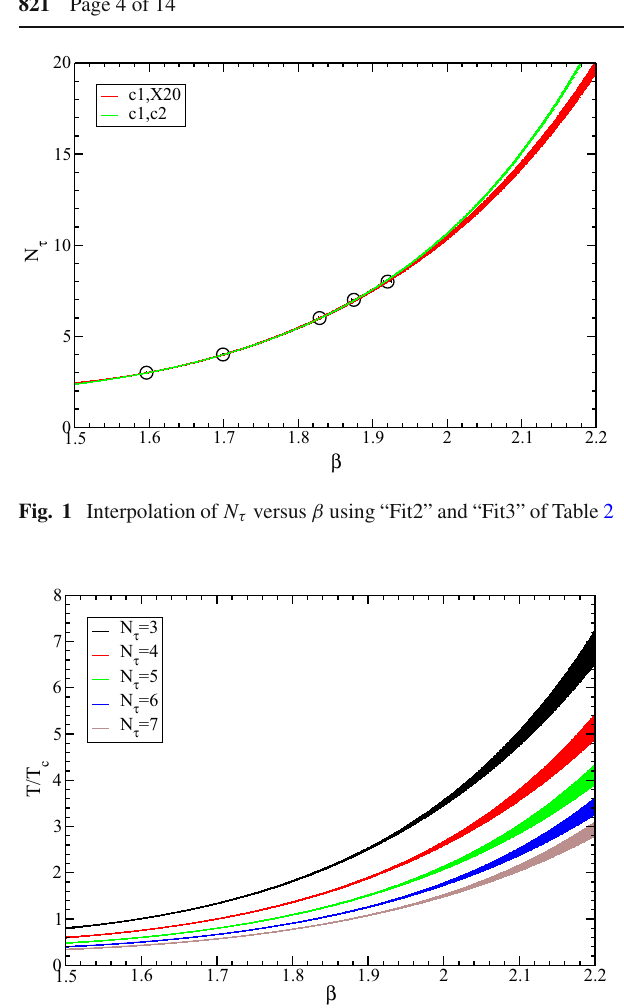
Fig. 2 T / T c versus β for different values of N τ . The error band has beendeterminedconsideringthesumofstatisticalandsystematicerrors due to the difference of the two interpolations of Fig. 1 and as central value the average of the interpolations